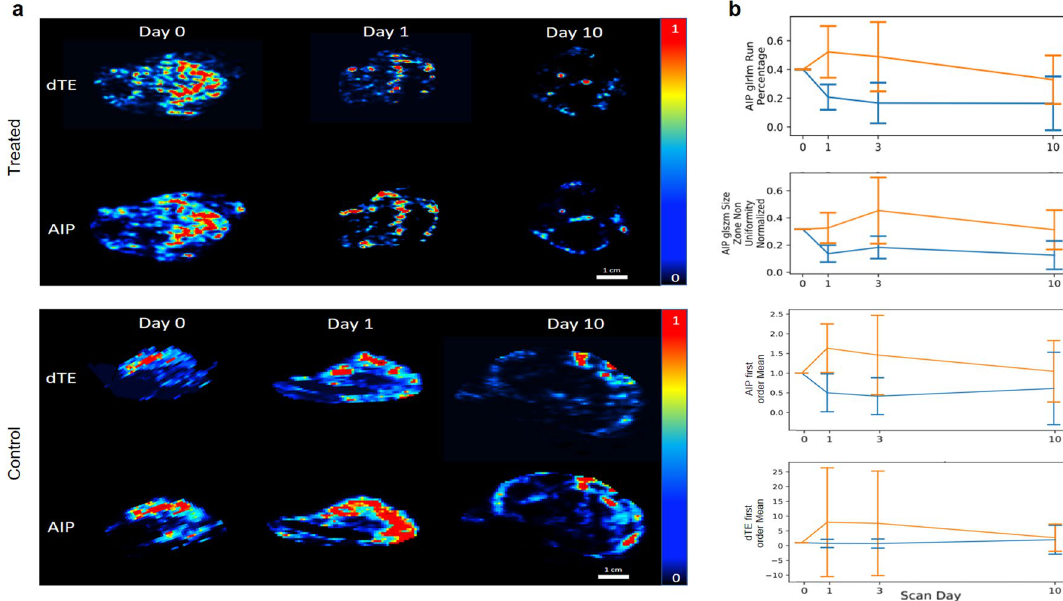
Figure 4. ( a ) Representative image data taken from a single transverse slice through the tumor volume of the AIP and dTE intensity maps of treated and control mice at scan days zero, one, and ten. Images are normalized for gray-scale to be 0–1 and displayed on a color map to allow visual comparison. ( b ) Time-series line plots of average per-animal image feature values with standard deviation error bar for treated animals (orange line) and control animals (blue lines). AIP image features selected at RFE. First order mean feature for AIP intensity map and dTE derived intensity maps showing less resolution of error bar compared to higher-order textural